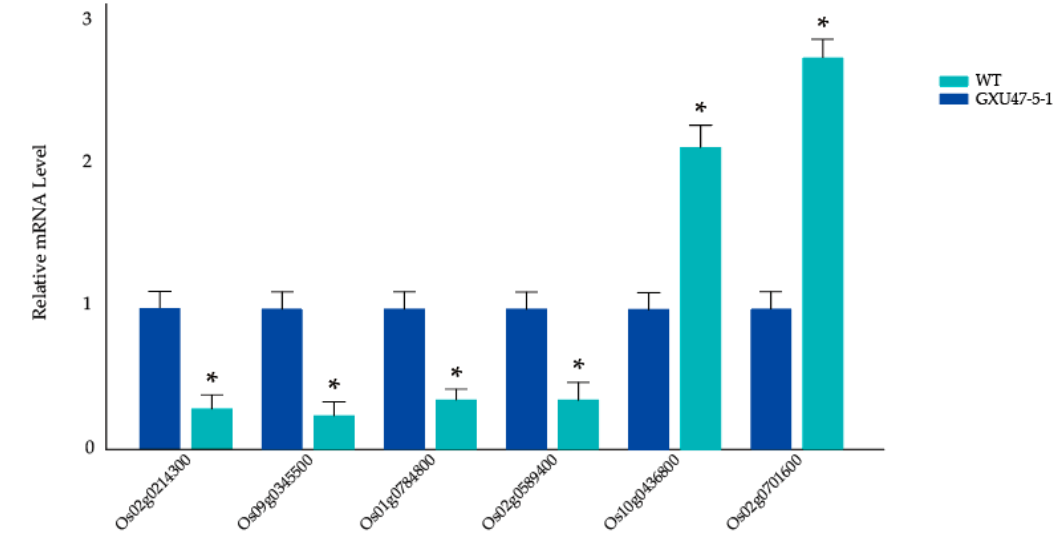
Figure 4. Relative expression levels of TMS5 (Os02g0214300) and responsive genes of five selected DEPs. WT is indicated in blue and GXU47-5-1 is indicated in cyan. Significant differences in the expression levels are indicated by “*”; Student’s t -test, p ≤ 0.05.